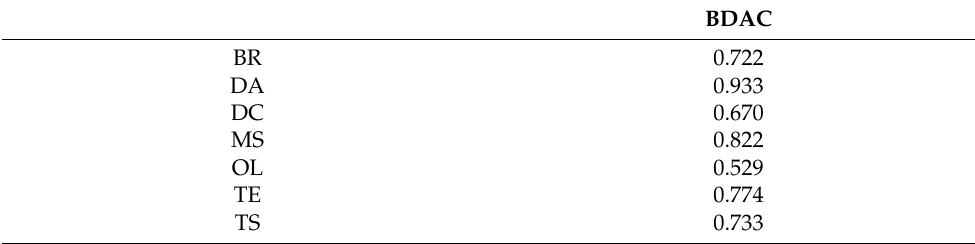
Table 3. Formative indicator’s outer